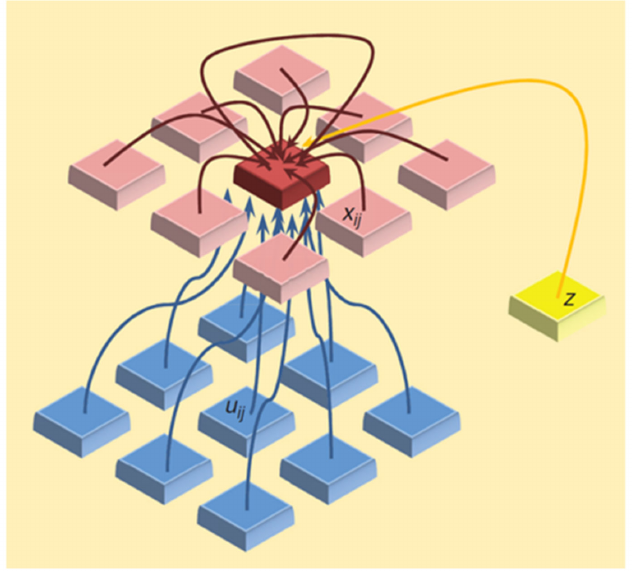
Figure 1. Illustration of the CNN coupling